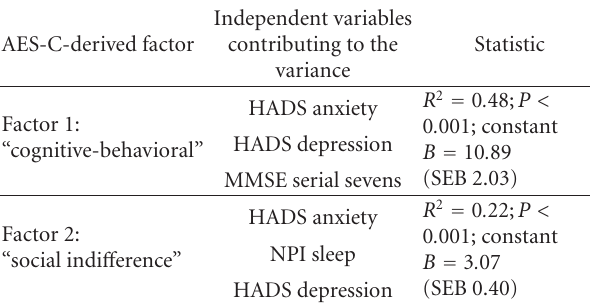
Table 5: Forced linear regressions with Apathy Evaluation Scale, Clinician version- (AES-C-) derived factors 1 and 2 as the dependent